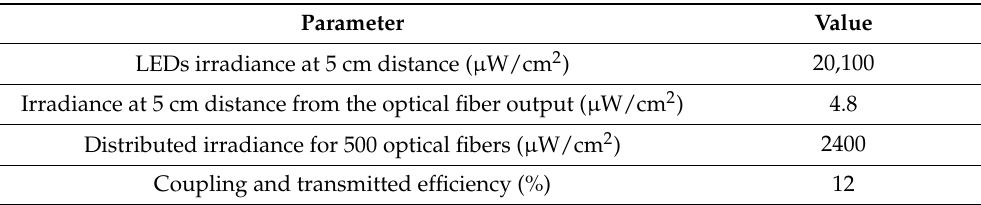
Table 3. Summary of the coupling efficiency experimental results.